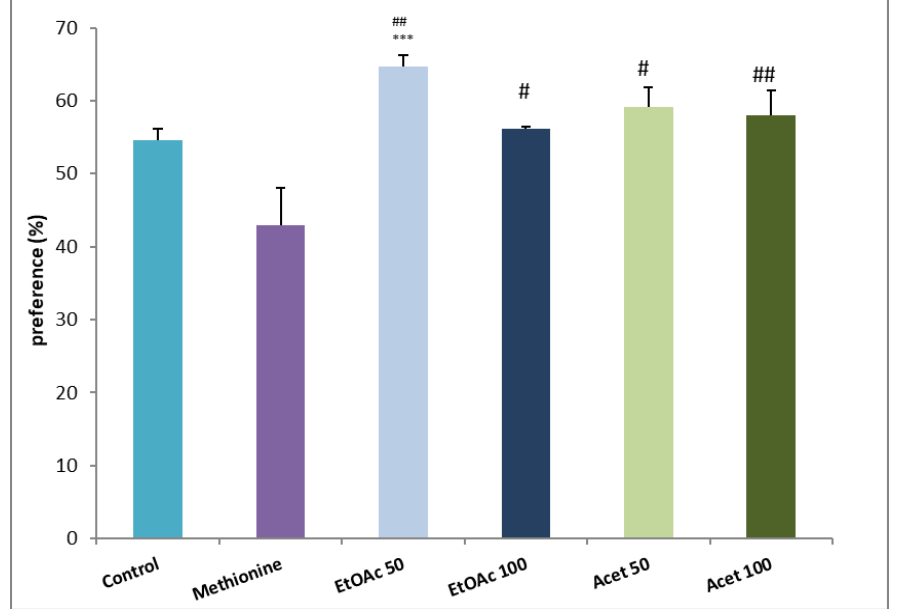
Figure 5. Effects of carob seed peel extracts on the preference percentage of the familiar object vs. the new object compared with control and methionine groups. *** p ≤ 0.001 comparing with control group and # p ≤ 0.05, ## p ≤ 0.01 vs. methionine group.